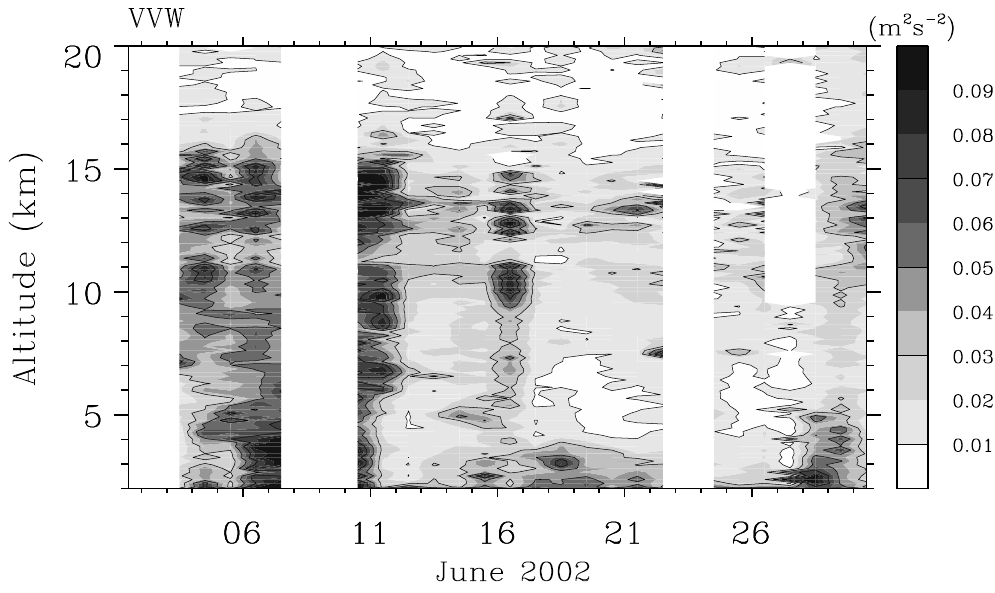
Fig. 13. Time-altitude plot of daily variance of vertical wind observed by EAR in June 2002.